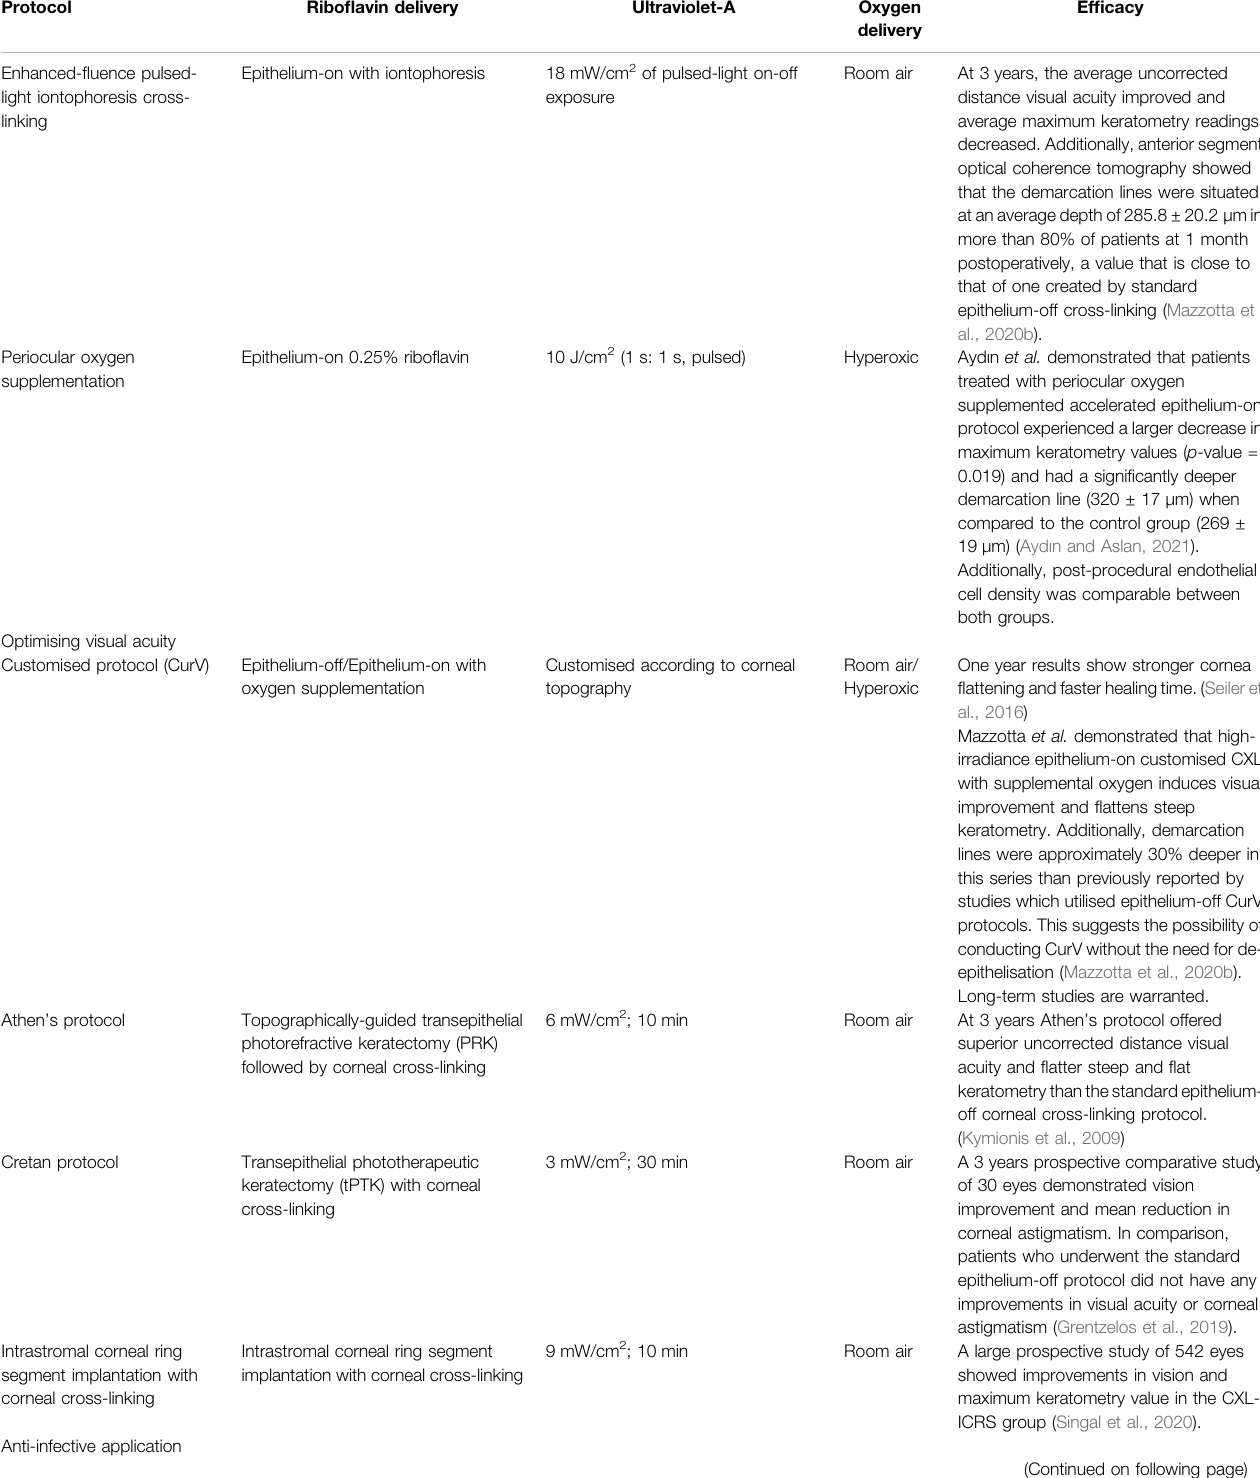
TABLE 1 | ( Continued ) Summary of existing corneal cross-linking